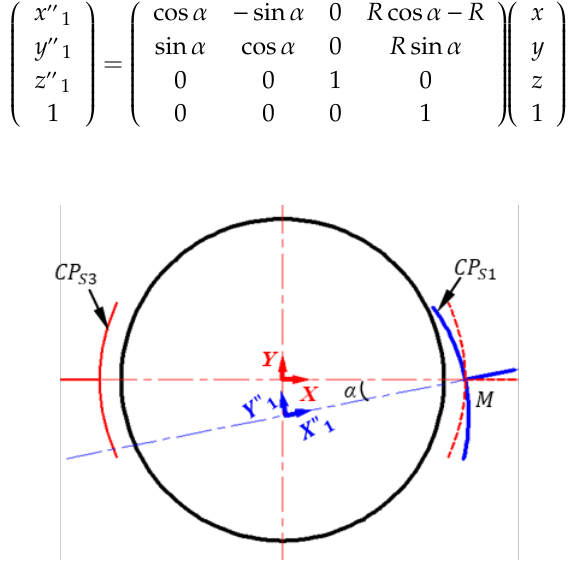
Figure 6. 2D sketch of spherical capacitive sensor C x with the inclined installation of the plate CP S1 .